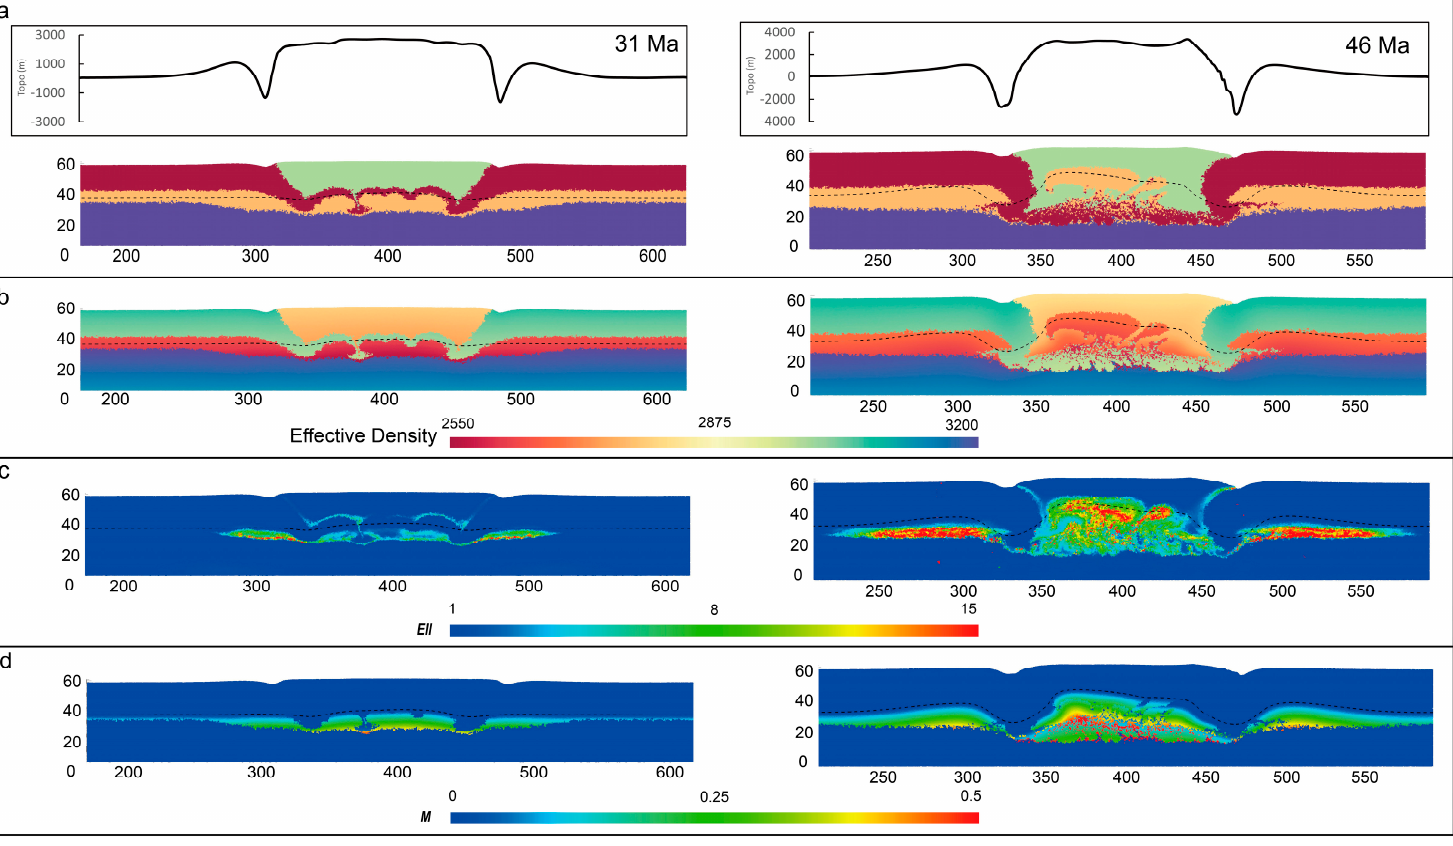
Figure 8. Model250, the width of sediment is set to 250 km. The solidus temperature of the lower crust is shown in dashed line. ( a ) At about 31 Ma, lower crustal rocks start to break through the mafic layer beneath the weak sediment. At 46 Ma, partially molten rocks ascend towards the sediment and form a diapir, which is wider than the diapir observed in Model250. ( b ) Effective density is calculated by Equations (5) and (6). ( c ) The accumulation ( EII ) of the second invariant of the strain rate ( ε II , s − 1 ) is employed to identify shear zones over time (calculated by (cid:1831)(cid:1835)(cid:1835) (cid:3404) ∑ (cid:2013) (cid:3010)(cid:3010)(cid:3047) (cid:2868) ∙ ∆(cid:1872) )). ( d ) Melt fraction is obtained by Equations (2) and (3).